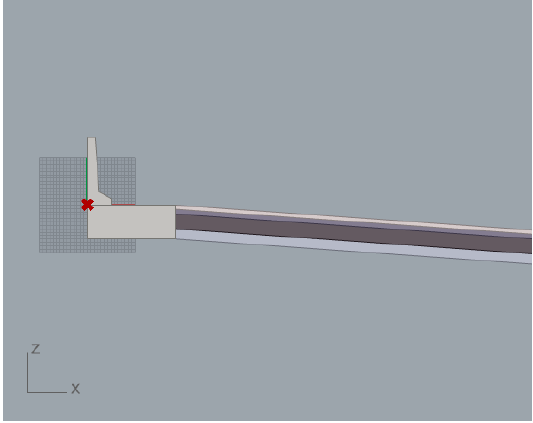
Figure 5. Road layers, divider and barrier planar surfaces.